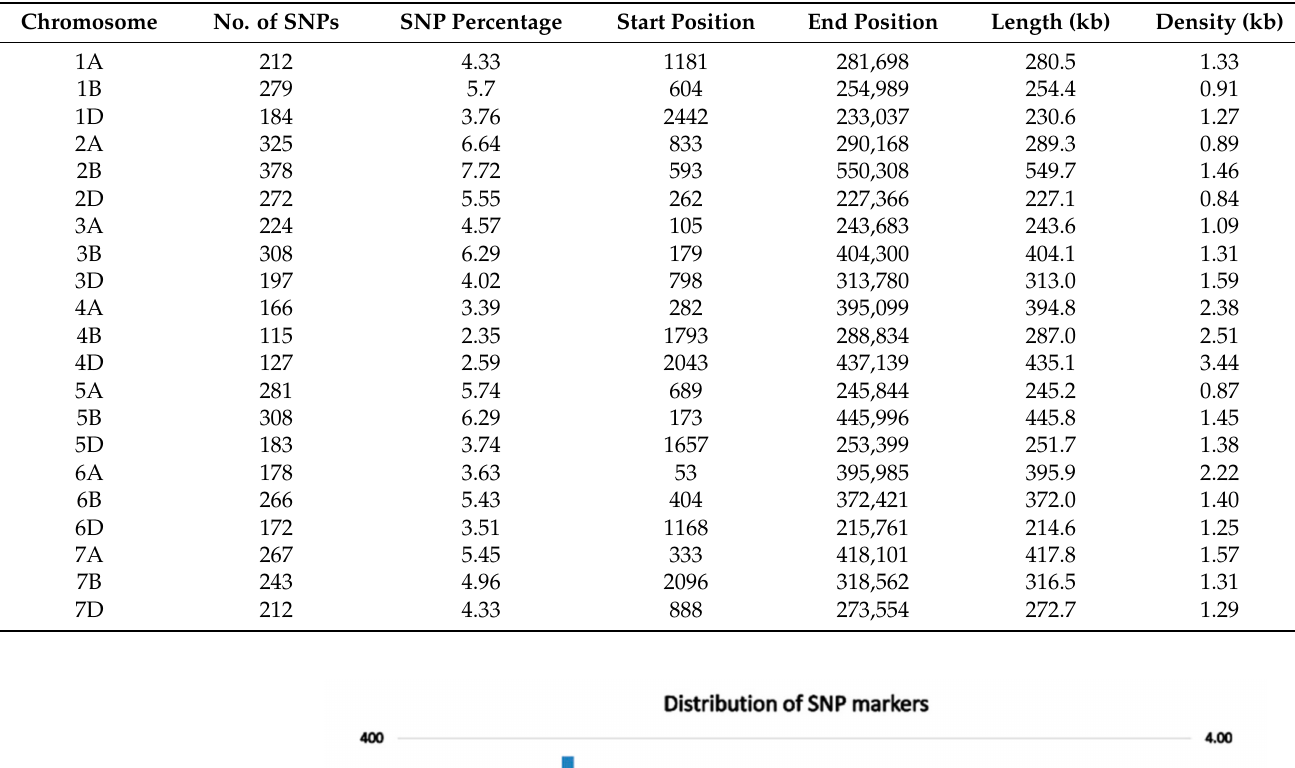
Table 1. Genomic distribution of 4897 SNPs mapped on 21 hexaploid wheat chromosomes.